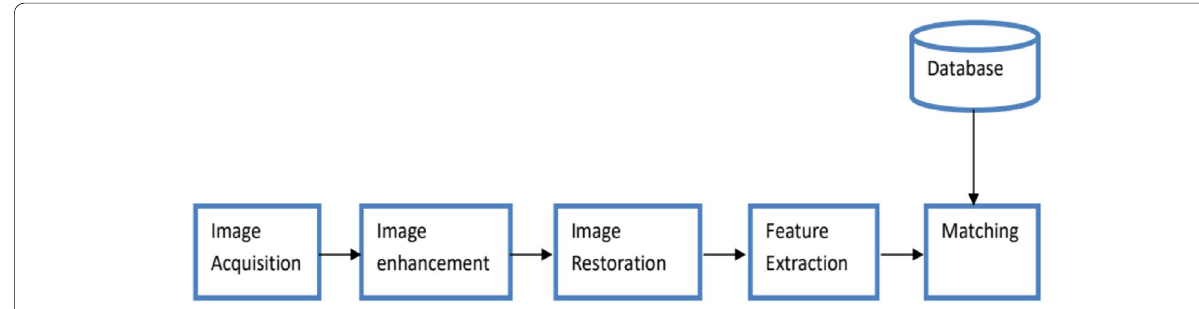
Fig. 2 The basic flow diagram of latent fingerprint processing (Jain & Feng, 2010a)